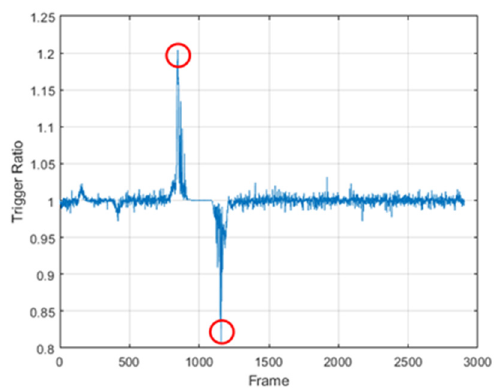
Figure 4. Example of the trigger ratio.